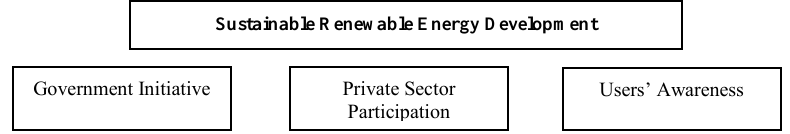
Fig. 1. Dimensions of Successful Renewable Energy Development in